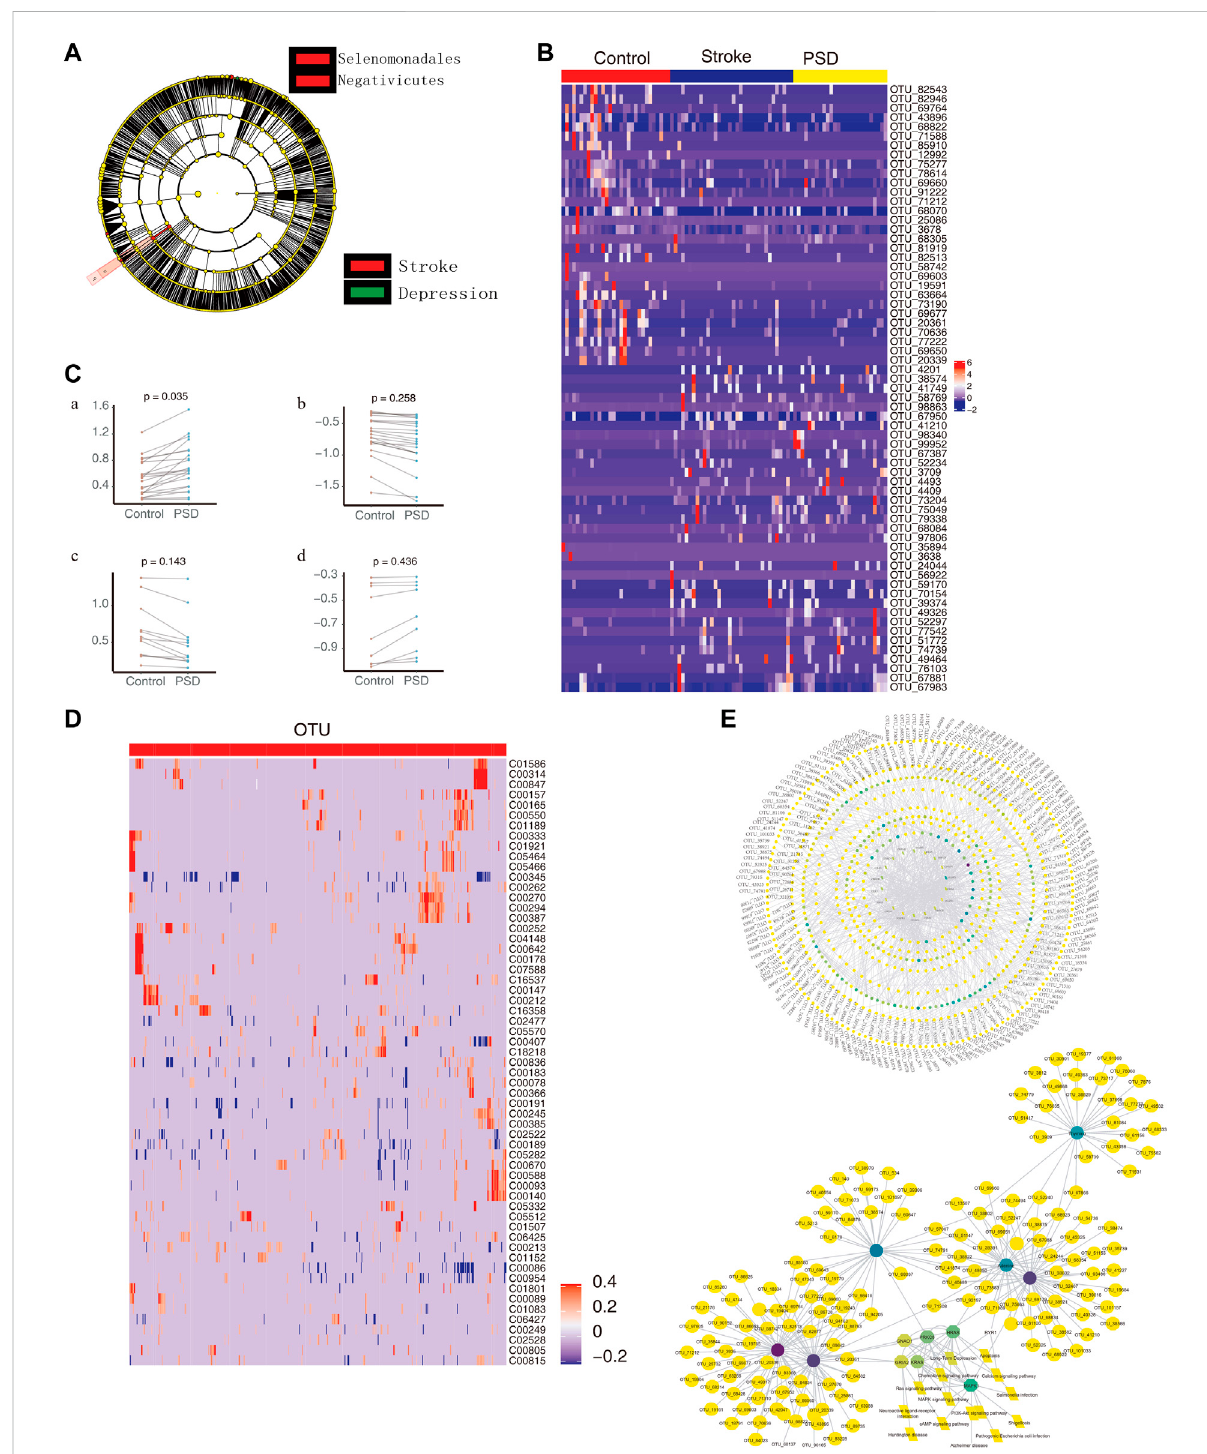
Intestinal microbes contribute to PSD depression with metabolic pathways. (A) . Evolutionary clade diagram. Group B indicates stroke patients; group C indicates PSD patients. (B) . Heatmap depicting the expression of common dysregulated microbes in healthy controls, stroke, and post- stroke depression patients. (C) . Paired scatterplot depicting changes in theabundance of common dysregulated microbes instroke and post-stroke depression patients. (D) . Correlation between dysregulated microorganisms and dysregulated metabolites. (E) . Global control network depicting differentially expressed genes (hexagons), metabolites (circles), microorganisms (squares), and pathways (diamonds). Note: Group B consists of stroke patients, and group C consists of PSD